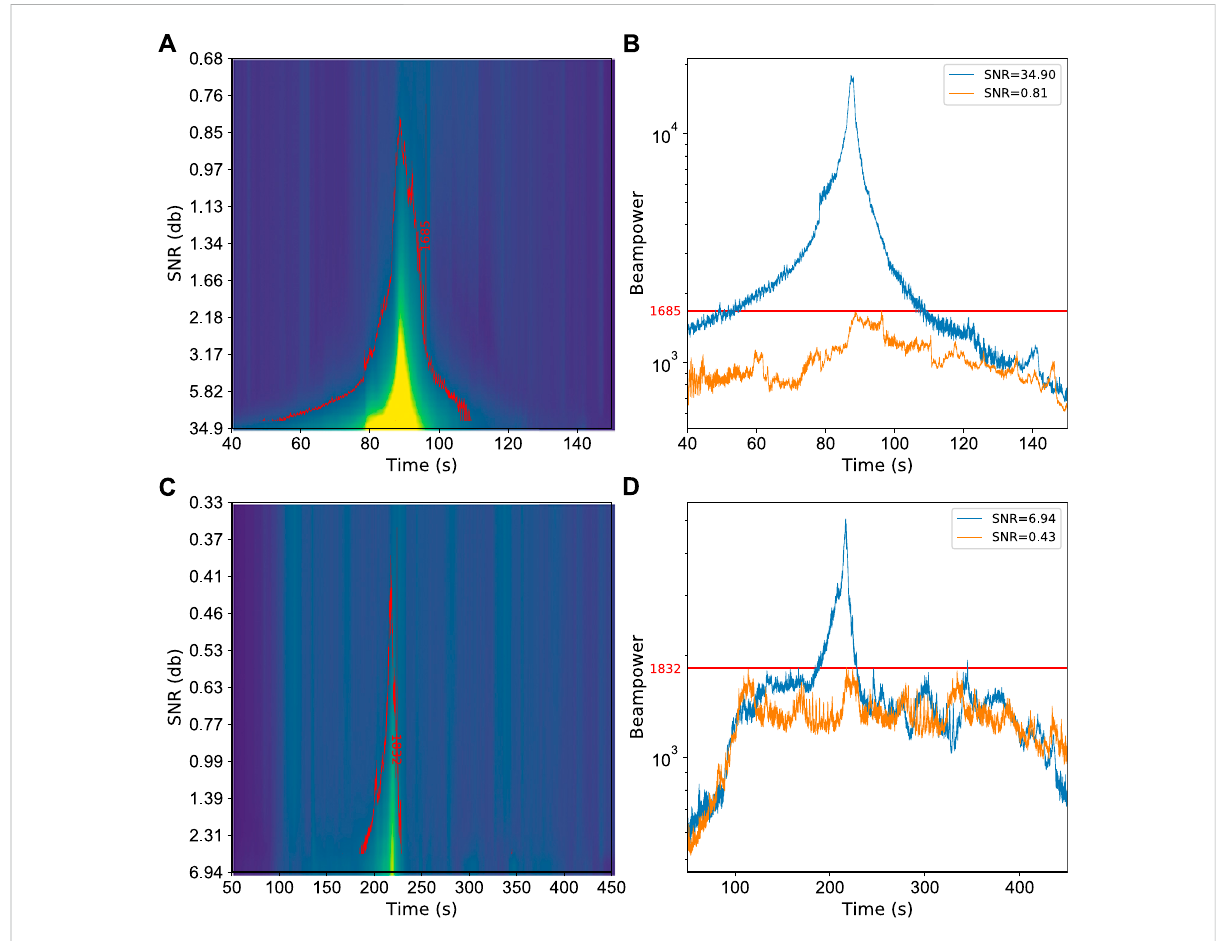
FIGURE 9 Examples of the beamforming performance in fl uenced by different SNR levels. (A) Collection of time-beampower curves with different SNRs foranEMUtrain(slicedfromthesegmentshowninFigure8A),theredcontourlinemarksthelowestbeampowervalueleadingtofalsedetection. (B) Time-beampower curves under high SNR (blue line) and low SNR (red line), the latter leads to false detection. (C) Same as (A) , but sliced from the segment shown in Figure 8D; (D) Same as (B) , but extracted from (C)